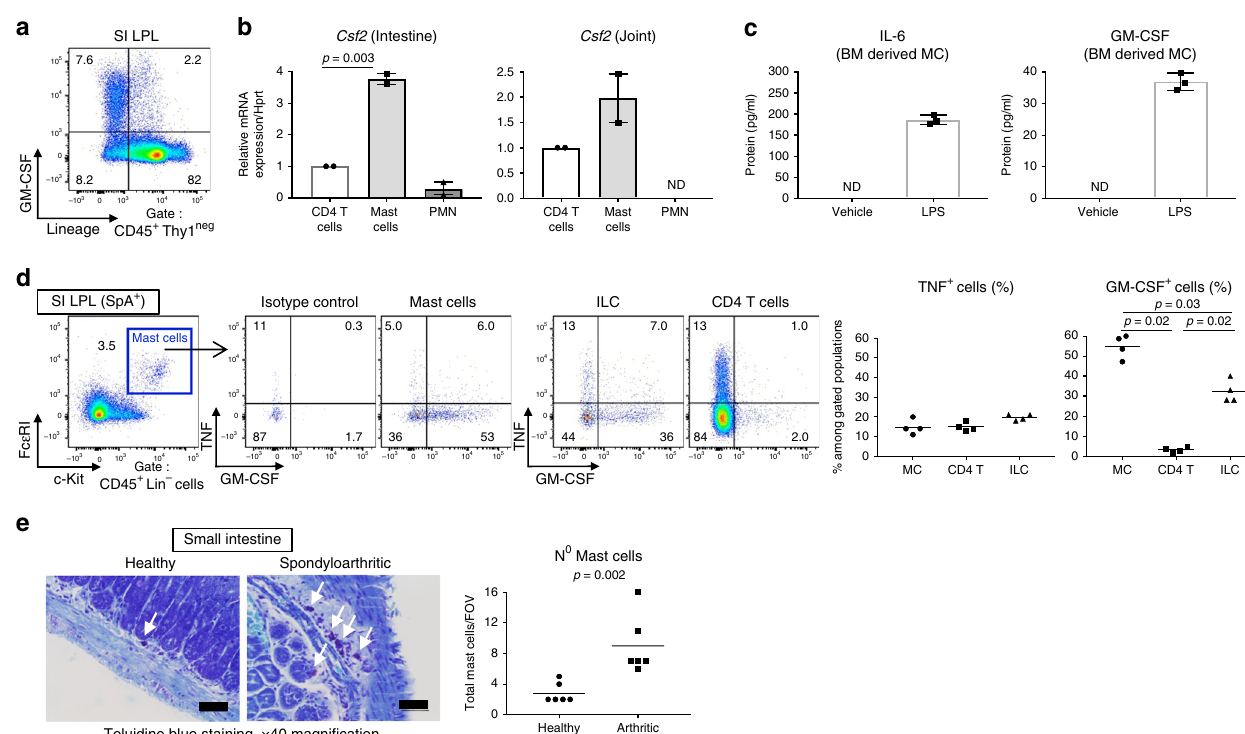
Fig. 5 Mast cells contribute to GM-CSF production in SpA. a Intracellular staining of GM-CSF + cells in in fl amed SI LPL from spondyloarthritic mice (week 4). b CD4 T cells, mast cells (MC) and neutrophils (PMN) were FACS-sorted from in fl amed SI and joints and mRNA levels of Csf2 were quanti fi ed by qPCR. Values are means relative to Csf2 levels in CD4 T cells (set to 1). Bars represent mean and SEM of 2 separate experiments. ND not detected. c BMMCs were challenged with PBS or LPS for 16 h and cytokine levels were measured by ELISA. Bars represent mean and SD of technical triplicates. d MC staining in in fl amed SI (week 4) and intracellular cytokine staining on MC, CD4 T cells, and ILCs (left). MC staining with an isotype control for GM-CSF is also depicted. Cells were incubated with brefeldin A only before staining. Frequencies of TNF + and GM-CSF + cells in indicated populations (right). e Photomicrographs of MCs in healthy and in fl amed SI (week 4) by toluidine blue staining (scale bars = 50 µ m) and absolute numbers of MCs per fi eld of view (FOV). Data are representative of three ( c , d ) or two ( e ) independent experiments. Groups were compared using Mann – Whitney U tests. Source data are provided as Source Data fi